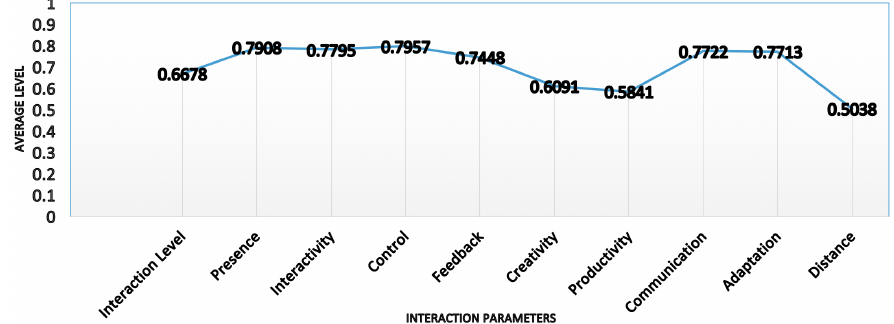
Figure 3. Average of interaction parameters. The figure shows the interaction parameters necessary to develop the adequate fuzzy inference system (FIS) in order to obtain the suitable interactive content